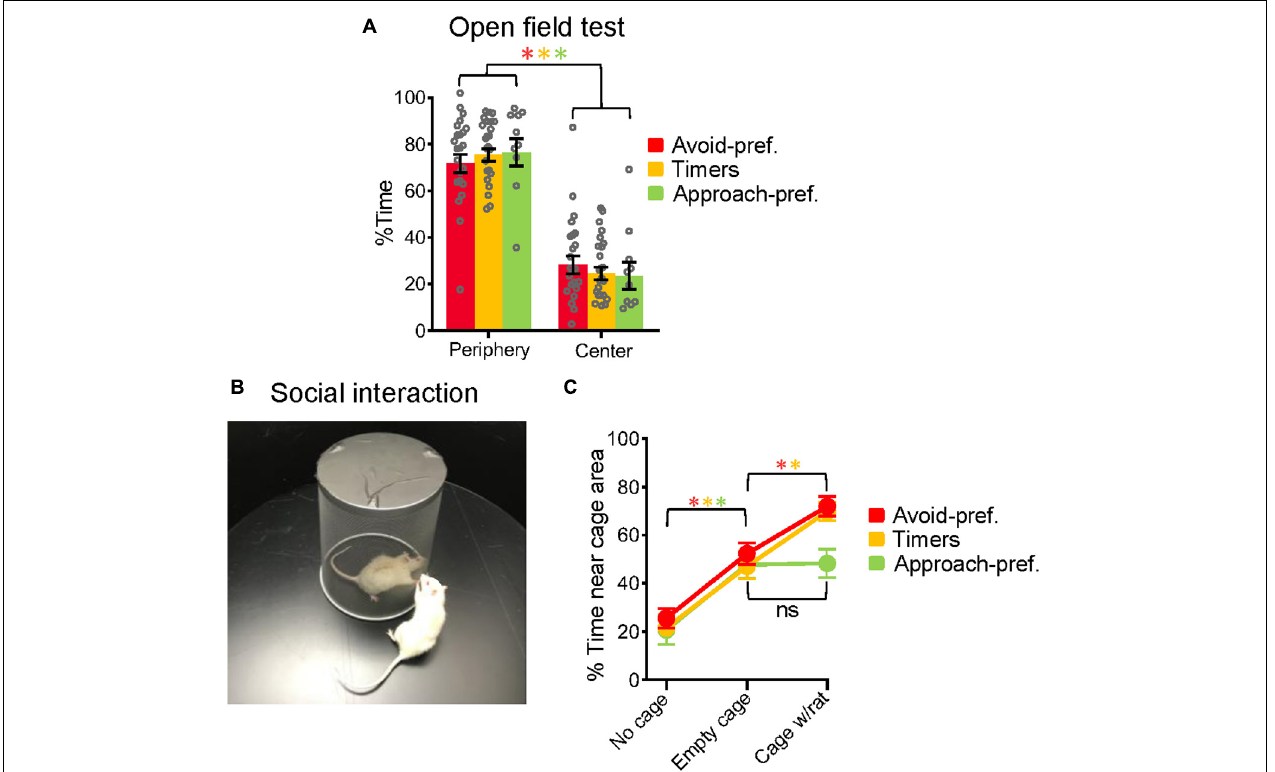
FIGURE 3 | Approach-preferring rats showed reduced social exploration. (A) The three subgroups showed no differences in the % of time exploring the center of the open field, a measure of innate fear. (B) Experimental setup for the exploration task in which rats could explore the outside of a novel cage that was first empty and later contained a demonstrator rat. (C) Placing the empty cage in the center of the open field increased the time spent exploring near the cage in all three subgroups. Adding a demonstrator rat to the empty cage further increased the time spent exploring for Avoid-pref. and Timer subgroups, but not in the Approach-pref. subgroup. Avoid-pref., n = 23; Timers, n = 24; Approach-pref., n = 10 (Student’s t -tests * p < 0.05, Bonferroni